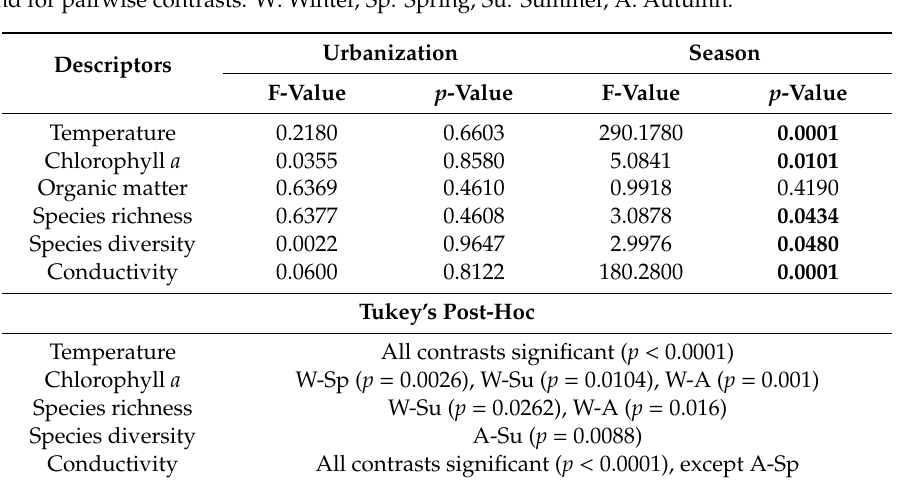
Table 3. Statistics of linear mixed effect models with two independent variables (urbanization and season) and their effect on abiotic and biotic descriptors of ciliate communities. Pairwise results of Tukey’s post hoc test provided below for significant models. Values in bold are statistically significant.